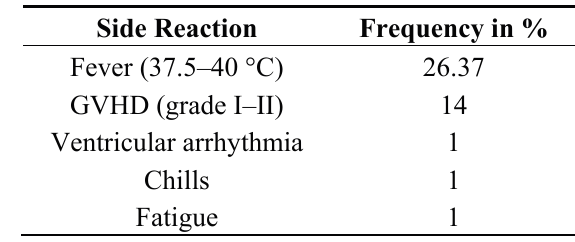
Table 1. Side reactions associated with CIK cell therapy. GVHD, graft- versus -host disease; CIK, cytokine-induced